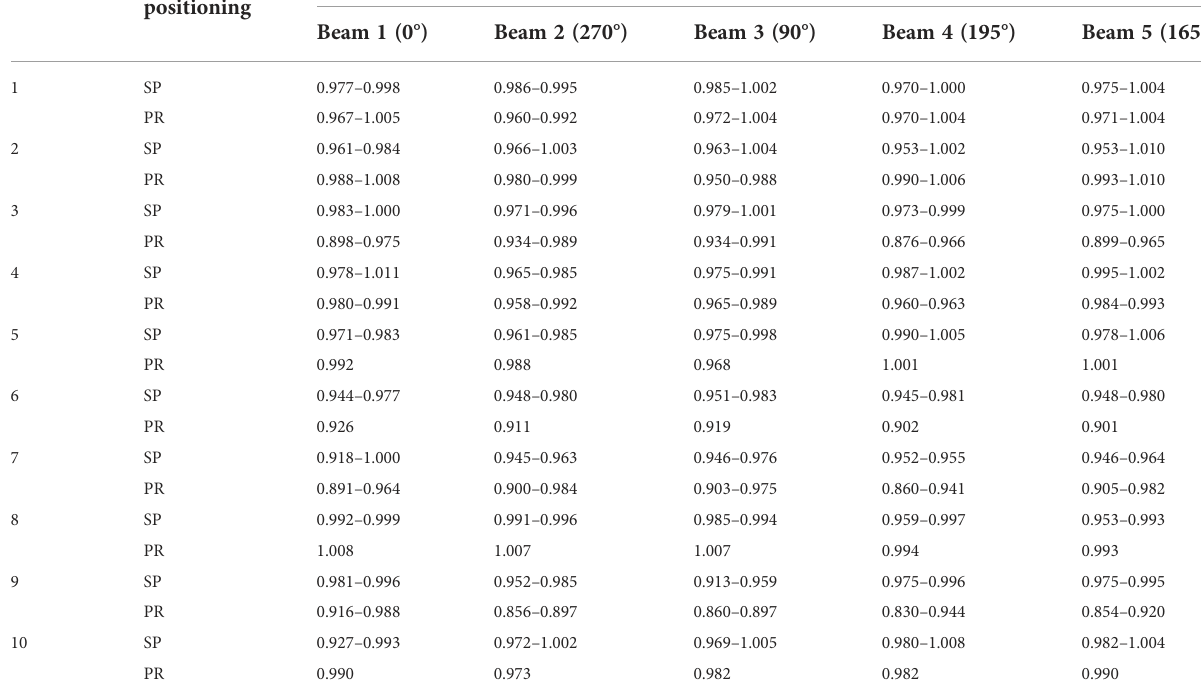
TABLE 3 Changes in factors other than gastrointestinal gas